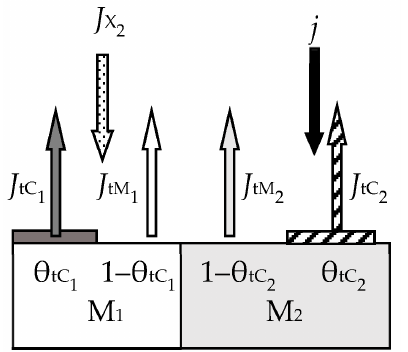
Figure 6. The fluxes on the target surface. Notations: J tM is the flux density of sputtered metal Figure 6. The fl uxes on the target surface. Notations: J tM is the fl ux density of spu tt ered metal atoms 1 1 atoms M 1 ; J tM is the flux density of sputtered metal atoms M 2 ; J tC is the flux density of sputtered M 1 ; J tM is the fl ux density of spu tt ered metal atoms M 2 ; J tC is the fl ux density of spu tt ered M 1 X 2 1 2 1 M 1 X molecules; J tC is the flux density of sputtered M 2 X molecules; θ tC is the fraction of the target molecules; J tC is the fl ux density of spu tt ered M 2 X molecules; θ tC is the fraction of the target surface 2 1 2 1 surface covered by the compound film M 1 X; θ tC is the fraction of the target surface covered by the 2 covered by the compound fi lm M 1 X; θ tC is the fraction of the target surface covered by the com- 2 compound film M 2 pound fi lm M 2 X.